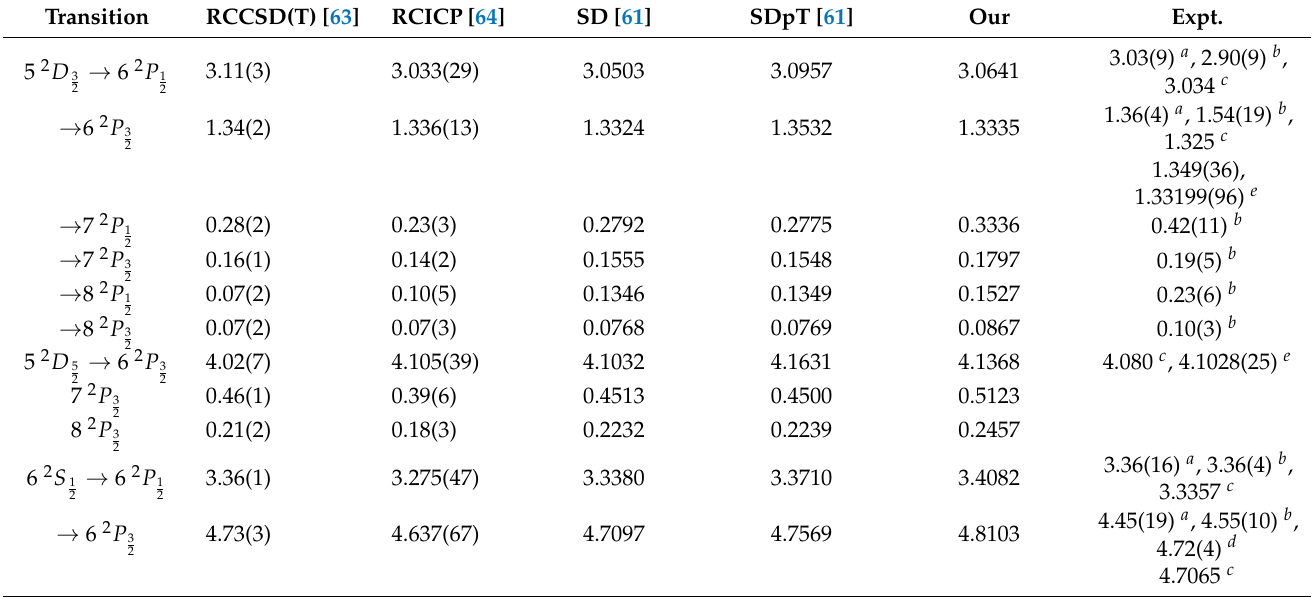
Figure 4. Variations in the polarizabilities (two-photon) with frequency ( ω 1 ) to extract the magic wavelengths (indicated in the panels in the unit of nm) in the presence of two counter-propagating linearly polarized lights with frequencies ω 1 and ω 2 . ( a , b ) represent transition among the states 6 2 S 1 2 ) levels of and 5 2 D 3 , and ( c , d ) represent transition among 6 2 S 1 and 5 2 D 5 . Here, the different ( J v , M J v 2 2 2 ( M ) . the state n 2 L J are indicated by nL J J v v v Table 2. The absolute values of our calculated reduced electric dipole matrix elements (indicated by ‘Our’) in a.u. are compared with few other theoretical and experimental (Expt.) values. Uncertainties of the results are mentioned in the parenthesis for the last